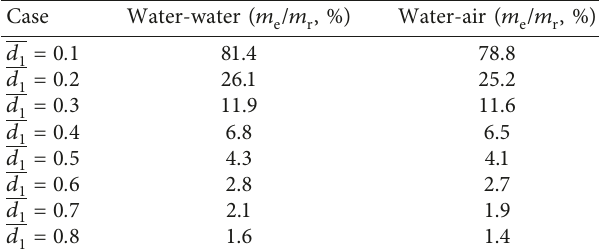
/ P for different outer shell 3 1 / m , e r